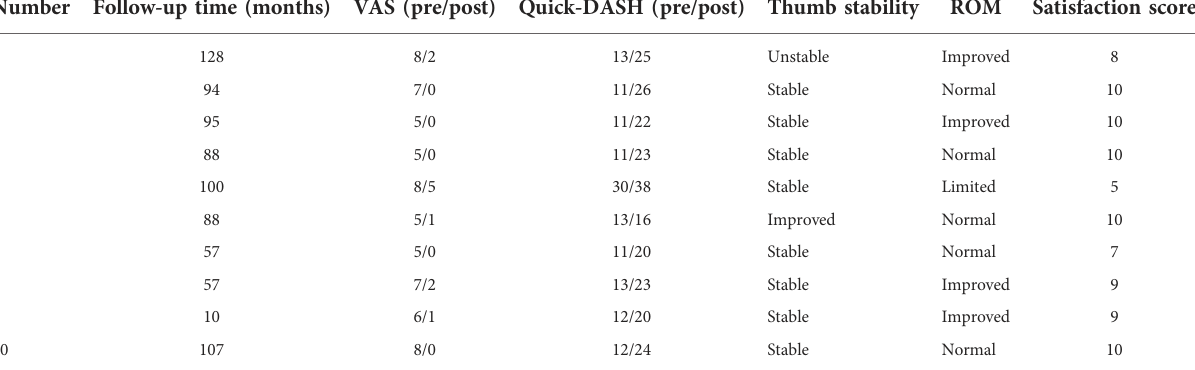
TABLE 3 Comparison of subjective outcomes in the preoperative period and the last